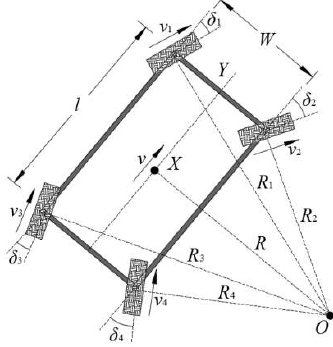
Figure 5. Kinematics model of the vehicle.